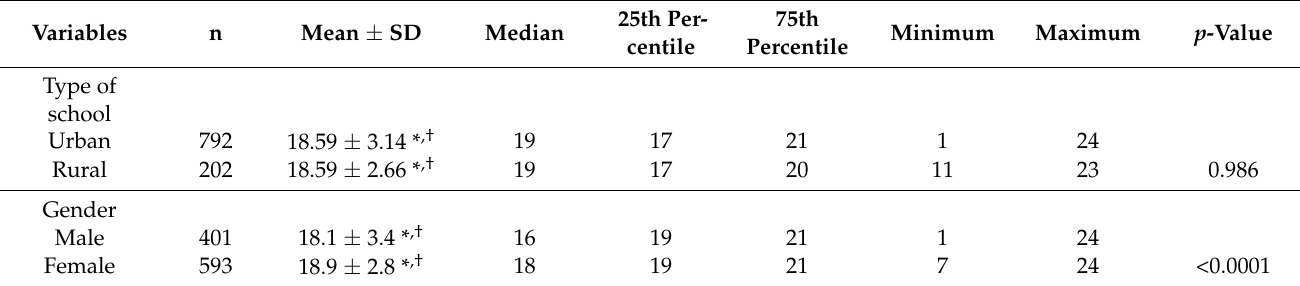
Table 2. Student nutritional knowledge based on locality of schools and